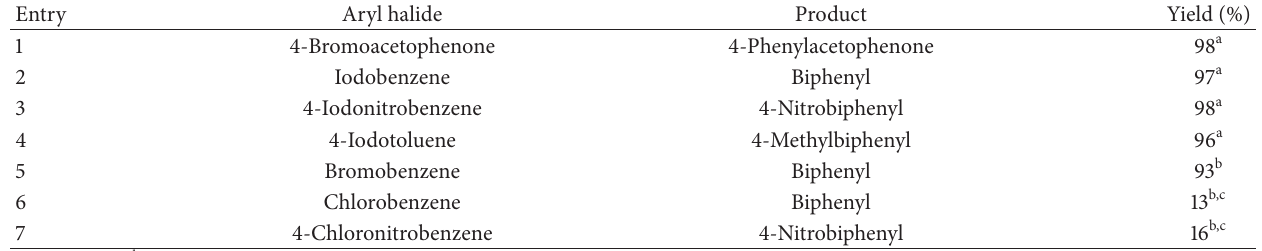
Table 4: Suzuki reactions between different aryl halides and phenylboronic acid using the ternary system (LDH-Pd-CD) at room temperature during 8 hours with 1:20 ratio of Pd: HP- 𝛽